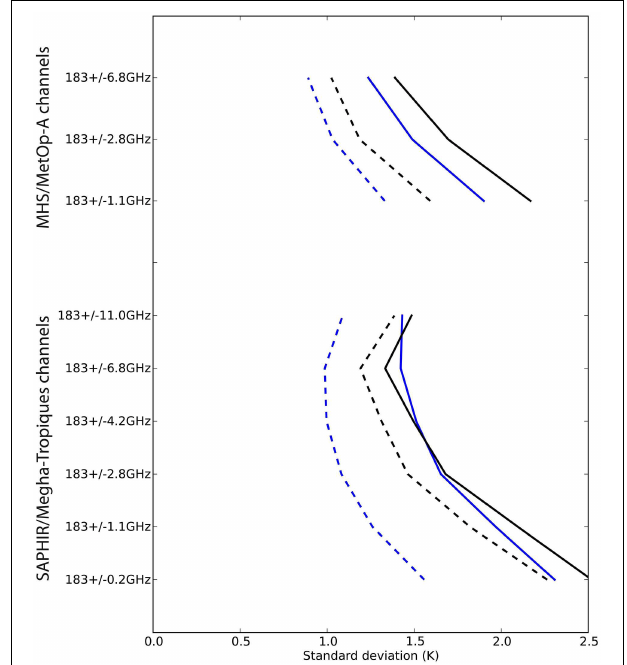
FIGURE 11 | Improvements of innovation statistics of MHS/MetOp-A and SAPHIR/MT when SAPHIR is assimilated into the ARPEGE global model operational at Météo France. Innovation statistics are defined as the standard deviation of difference: observation minus model-simulated observations. In full lines, the simulated observations are based on short-range model forecasts and in dashed lines they are based on model analyses. Black lines are for the control experiment, and blue lines correspond to the experiment with SAPHIR data assimilated. From Chambon et al.